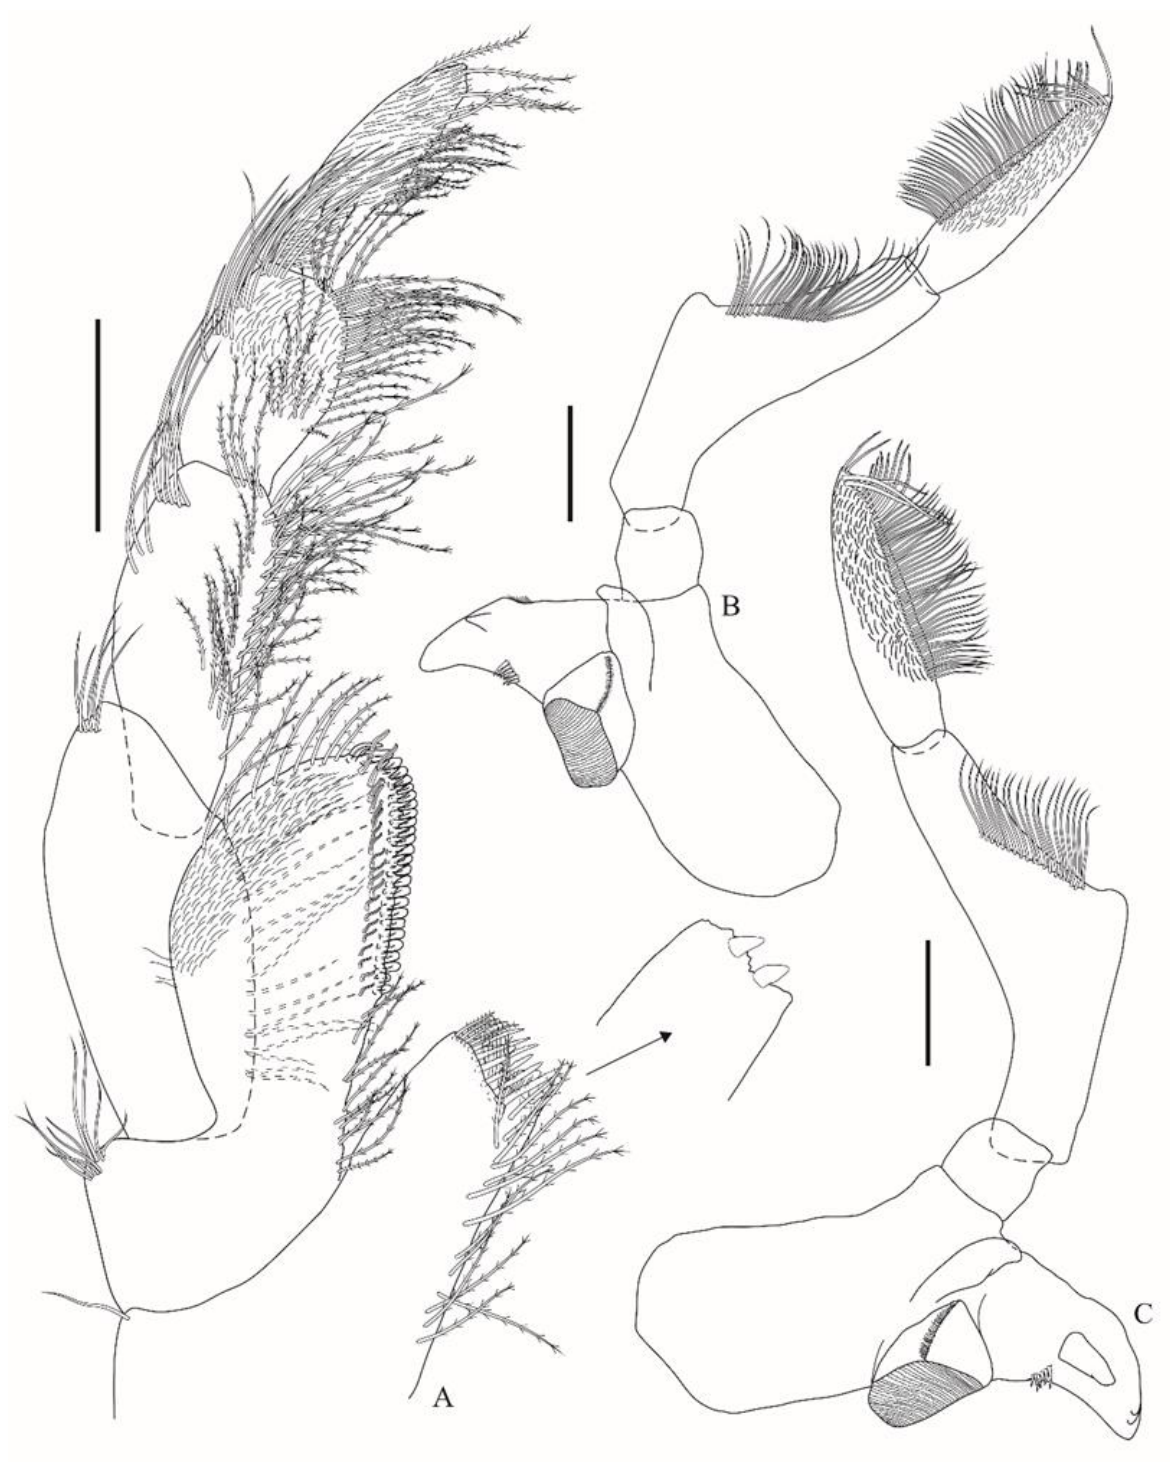
Figure 3. Cyphocaris boecki sp. nov., female holotype, 33.3 mm (MOUFPE 20068). ( A ) Maxilliped; ( B ) right mandible; ( C ) left mandible. Scale bars: 0.5 mm.